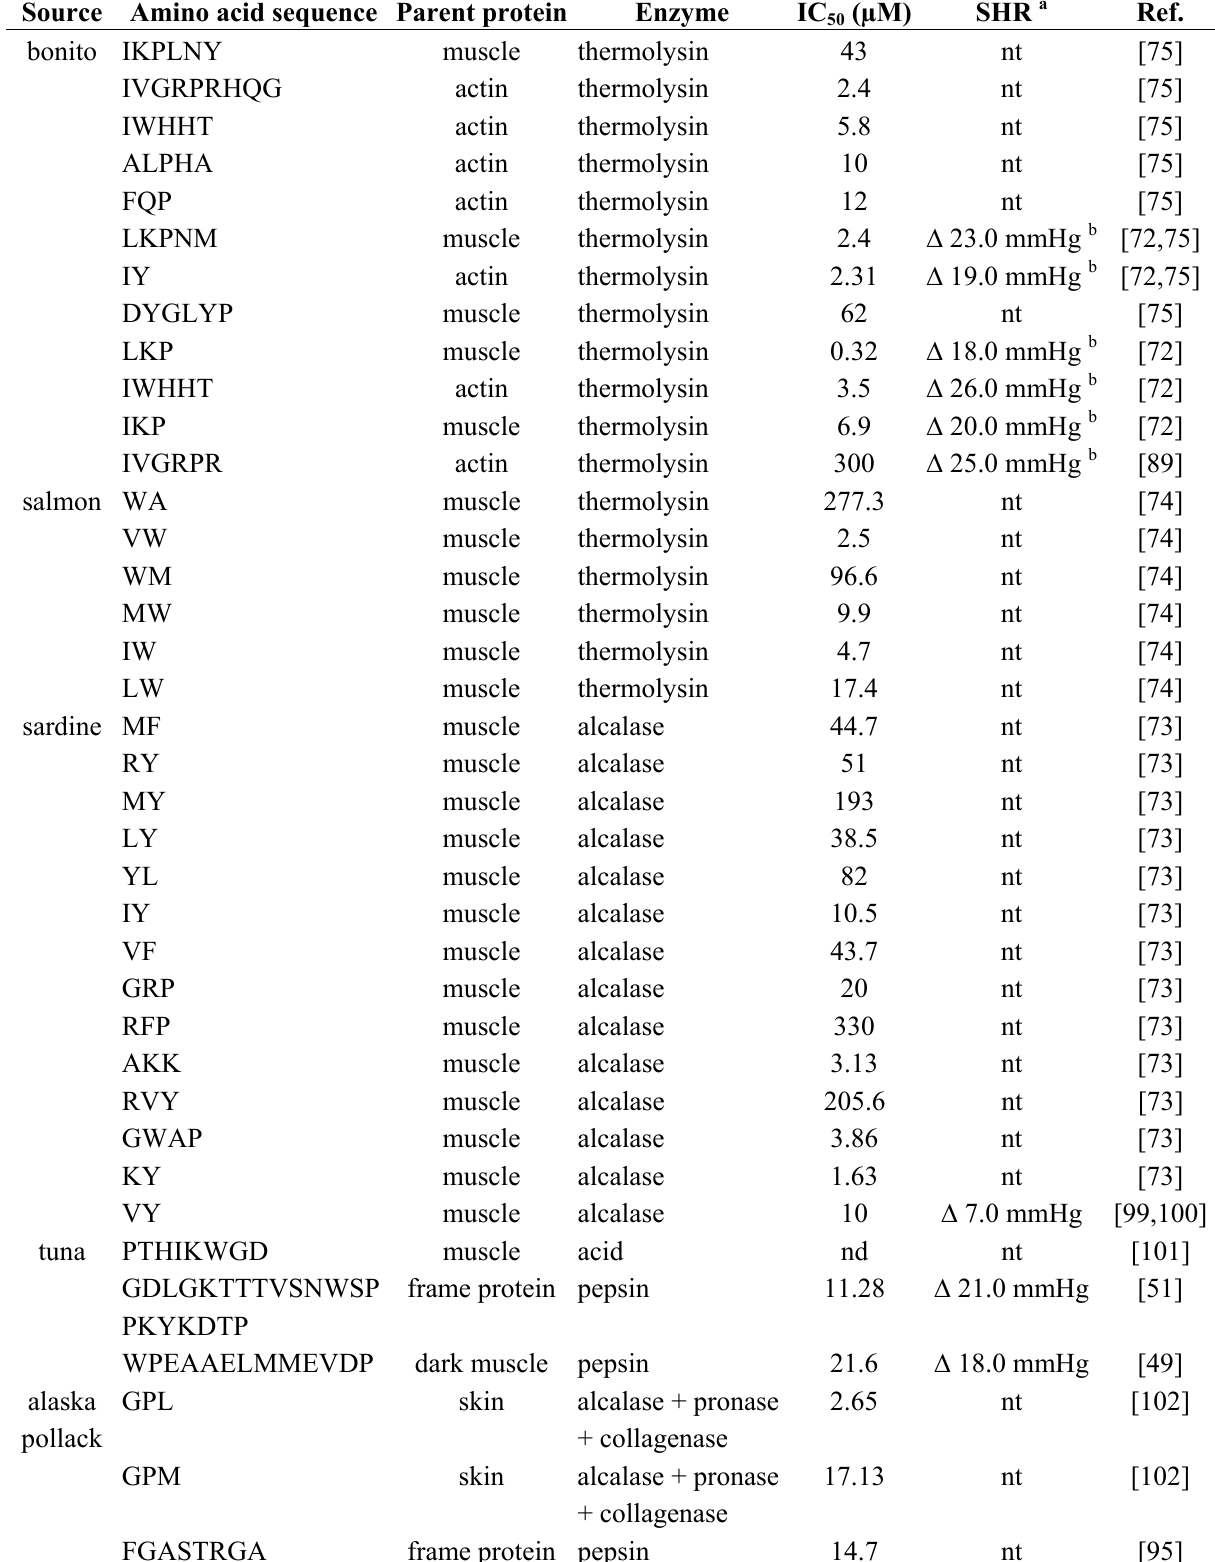
Table 2. ACE inhibitory peptides derived from meat of fish. Adapted with permission from American Chemical Society [3], Copyright